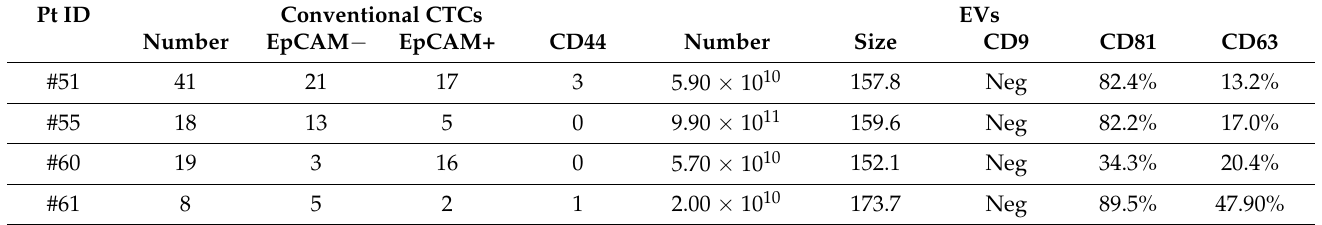
Table 3. CTC and EV physical and phenotypic properties.